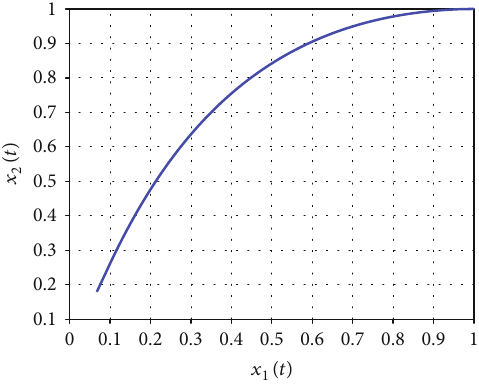
Figure 3: The numerical results for system (60) at c ð μ Þ = − δ ð μ − 2 /3 Þ for Example 20.